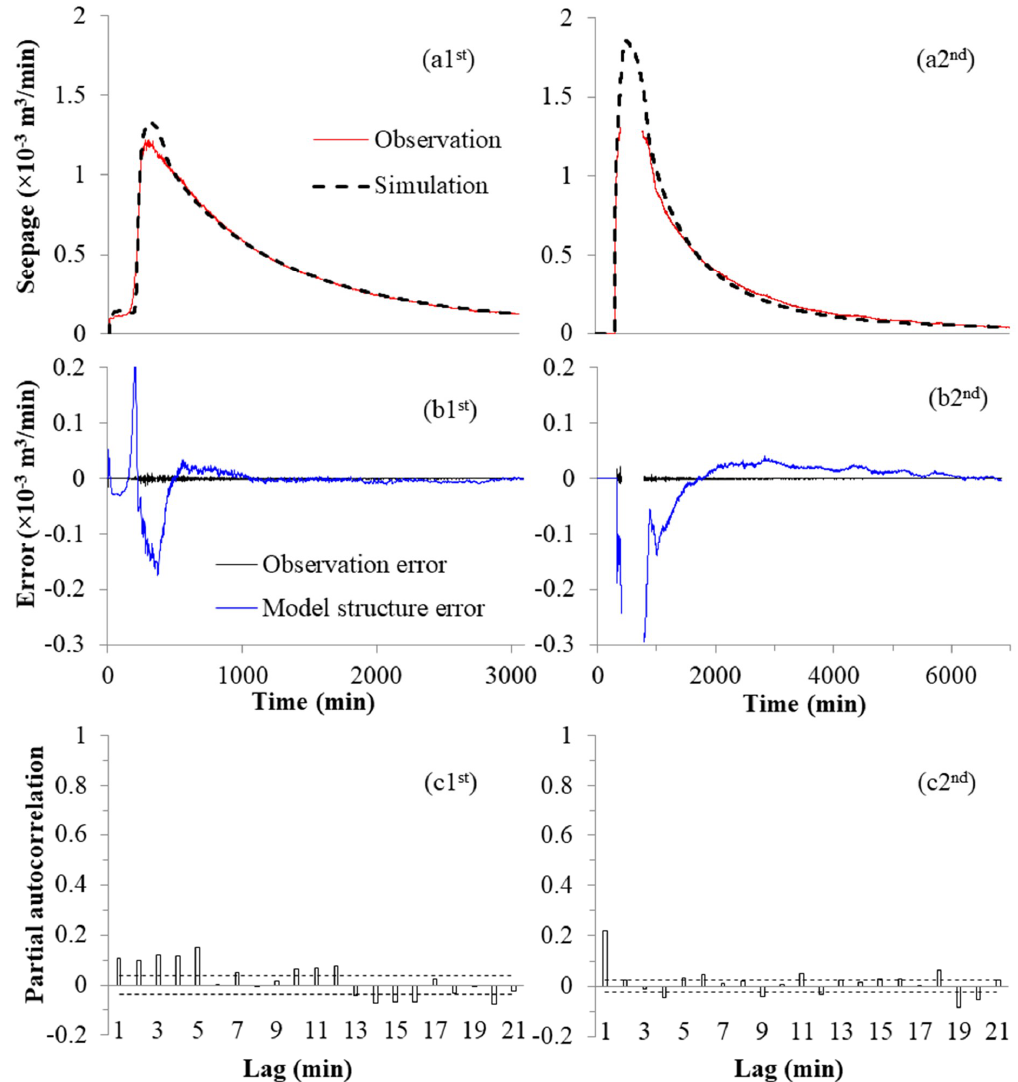
Figure 5. Error analysis for the simulated seepages of the practical formal likelihood function (L) method. ( a ) Comparison between the observed and simulated soil tank seepages. ( b ) Decomposition of the model residuals into model structural and observational errors. ( c ) Partial autocorrelation coefficients of model structural errors after AR(1). Left column is for the first experiment and right column is for the second